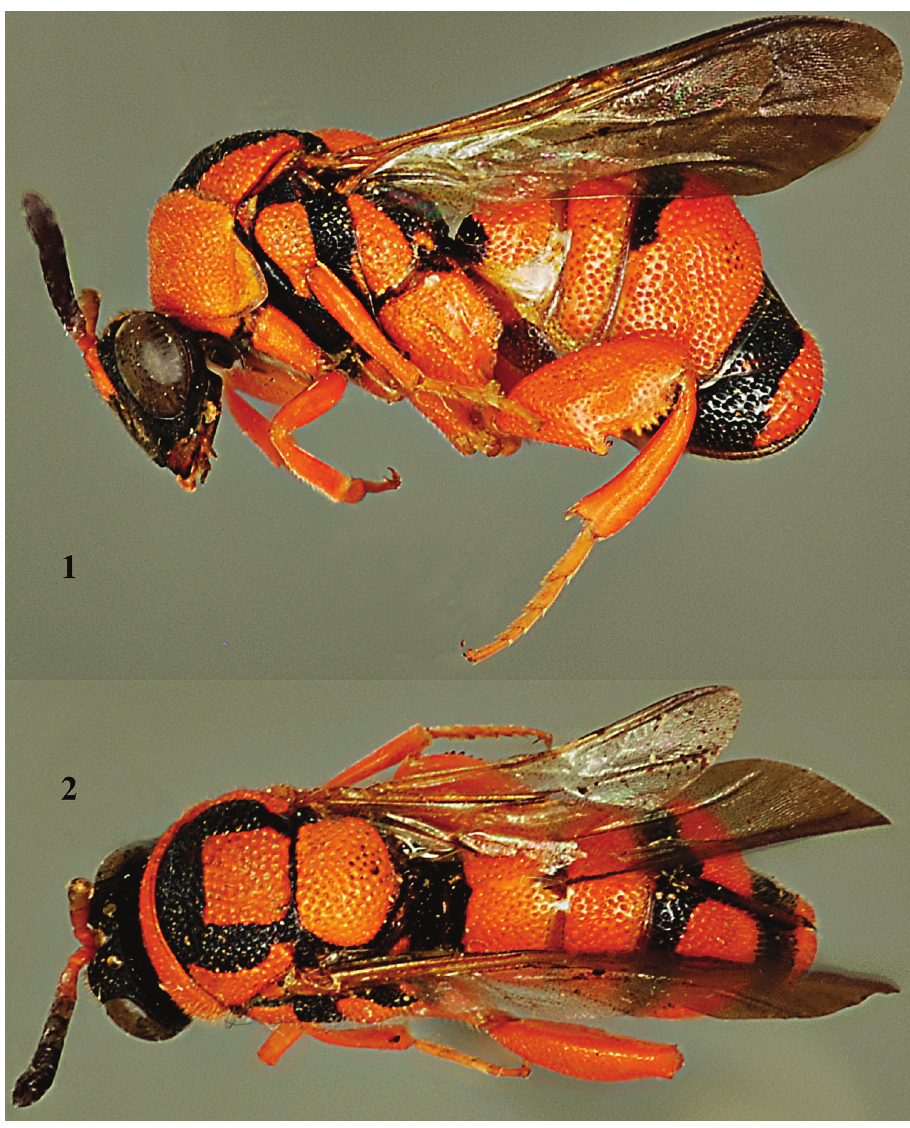
Figures 1, 2. Leucospis aurantiaca Shestakov, ♀ , lectotype. 1 Habitus lateral 2 habitus dorsal (courtesy of Mr. Paolo